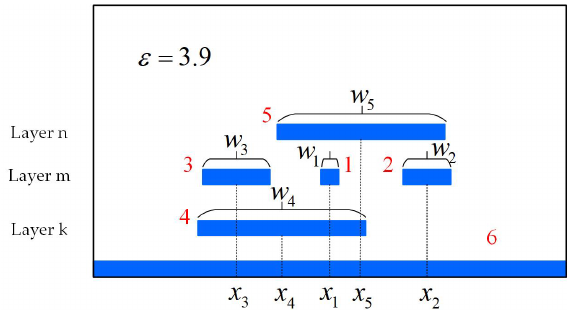
Figure 2. T he illustration of the studied pattern and its geometry variables. Figure 2. The illustration of the studied pattern and its geometry